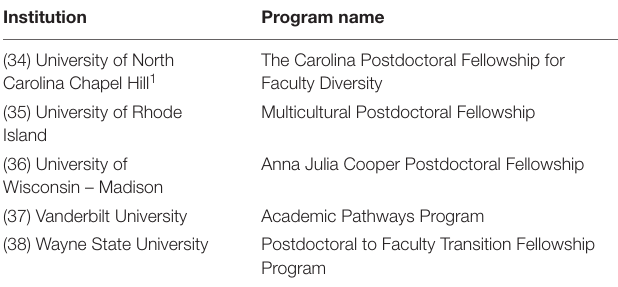
TABLE 2 | Postdoc-to-tenure track conversion programs in United